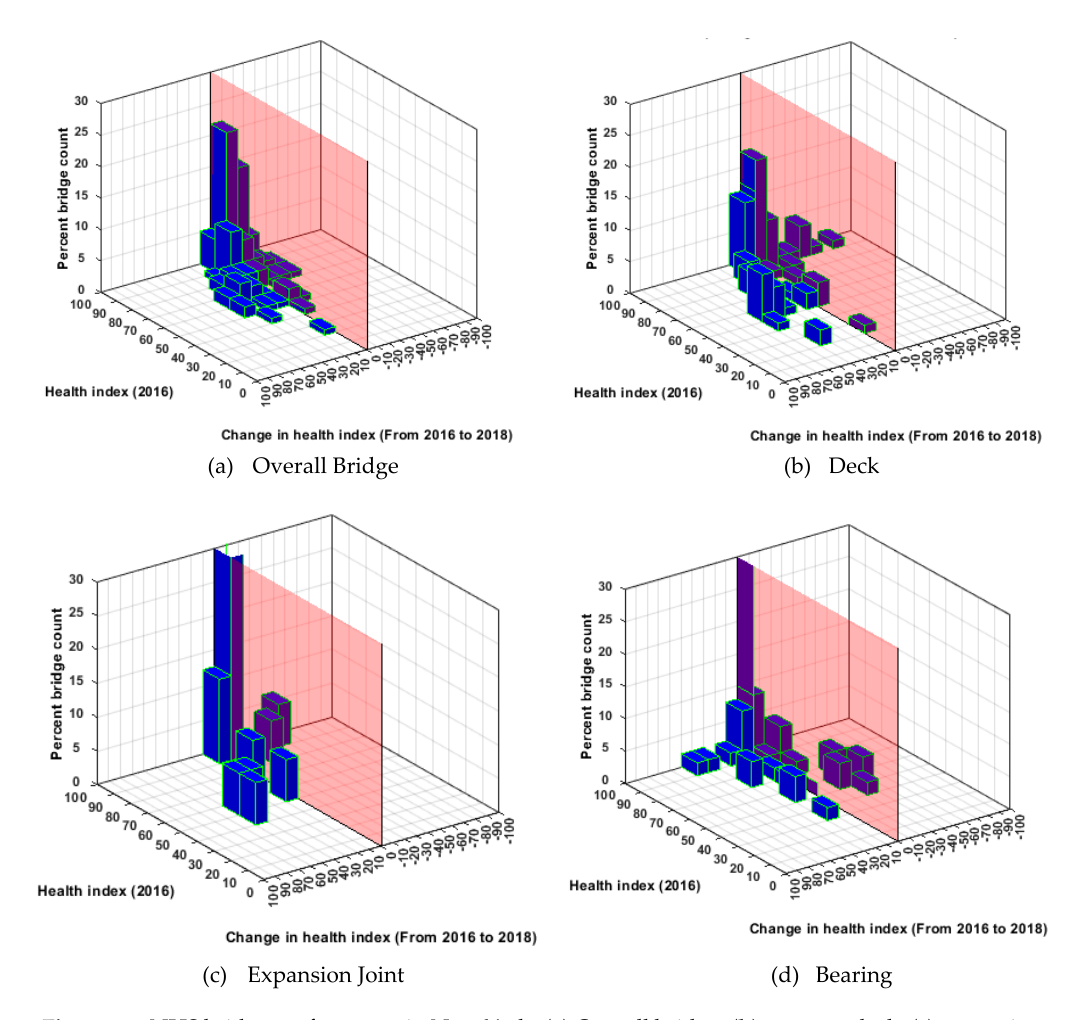
Figure 16. NHS bridge performance in New York. ( a ) Overall bridge; ( b ) concrete deck; ( c ) expansion joint; ( d ) bearing.